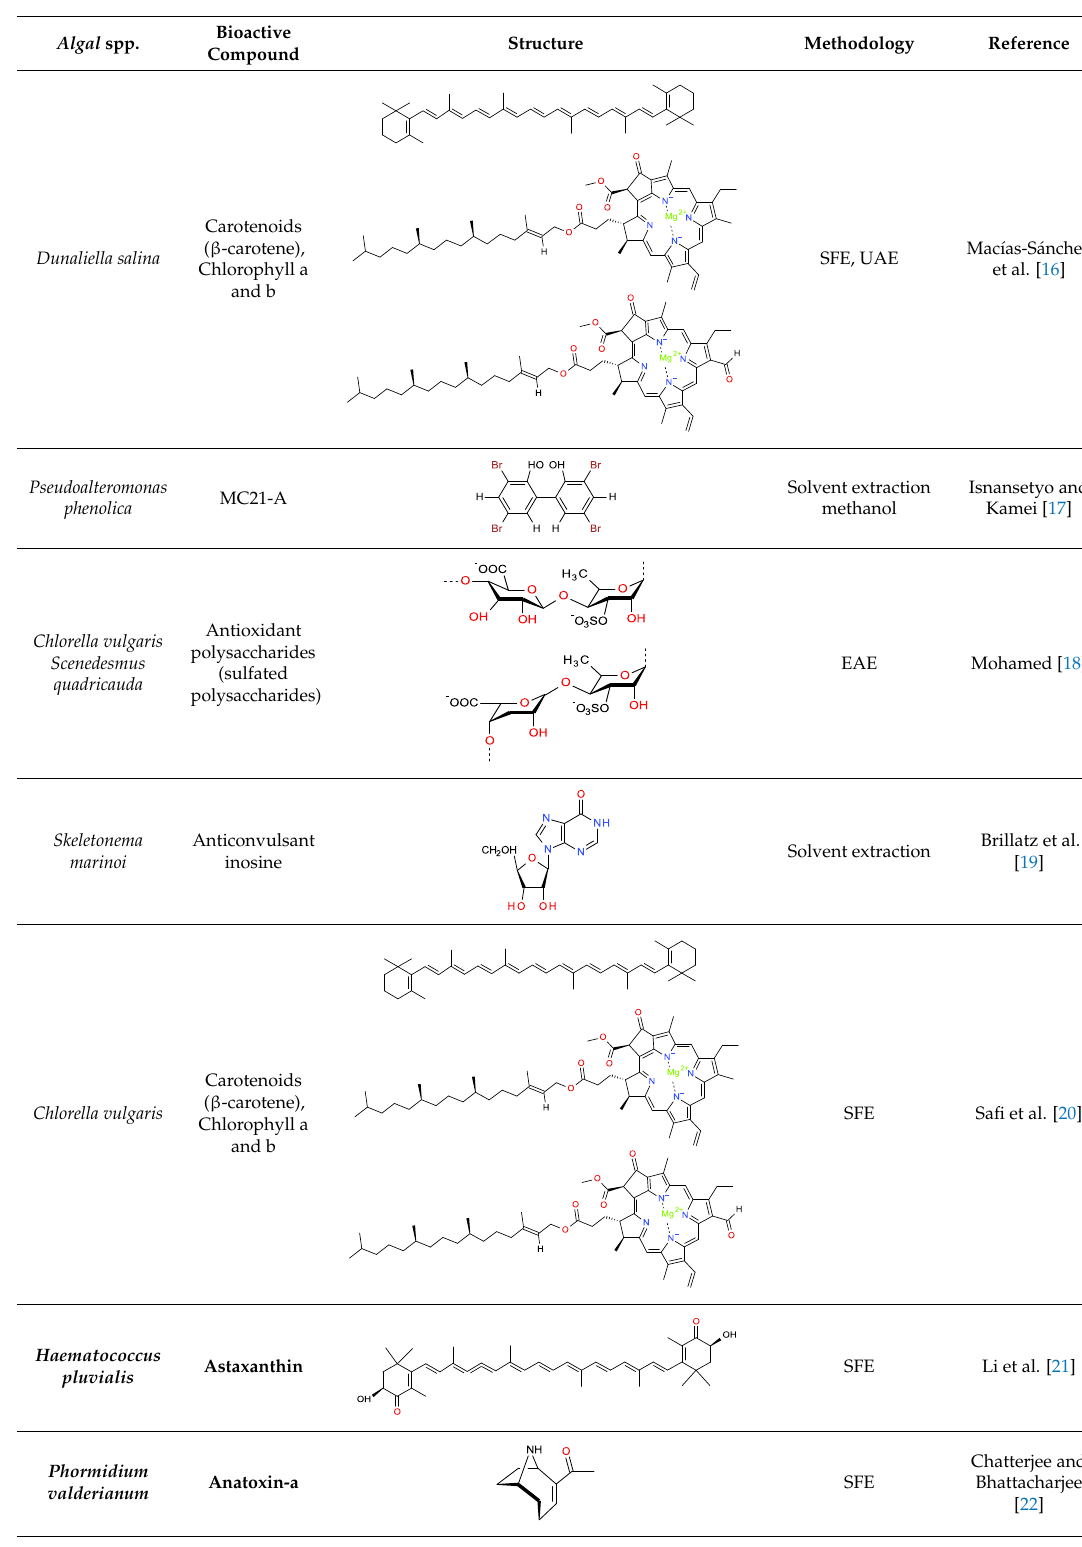
Table 1. Algal biome as a prolific source of bioactive compounds.